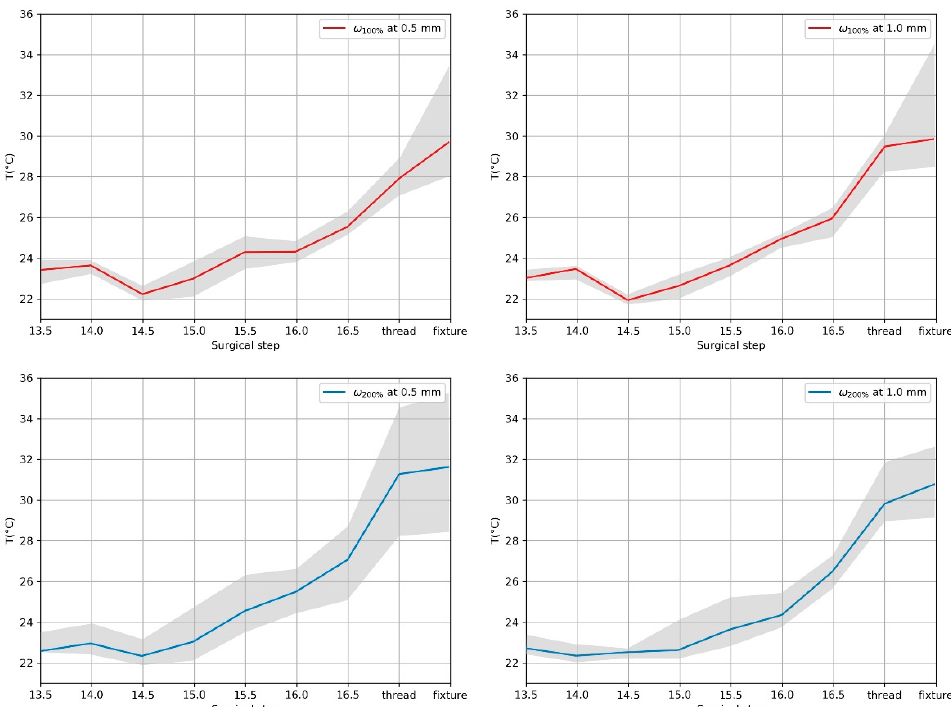
Figure 6. Cumulative heat generation during the simulated surgery for the two different speeds at 0.5 and 1.0 mm from the implant surface. The solid lines represent the median, and the shaded area represents the corresponding 25th to 75th